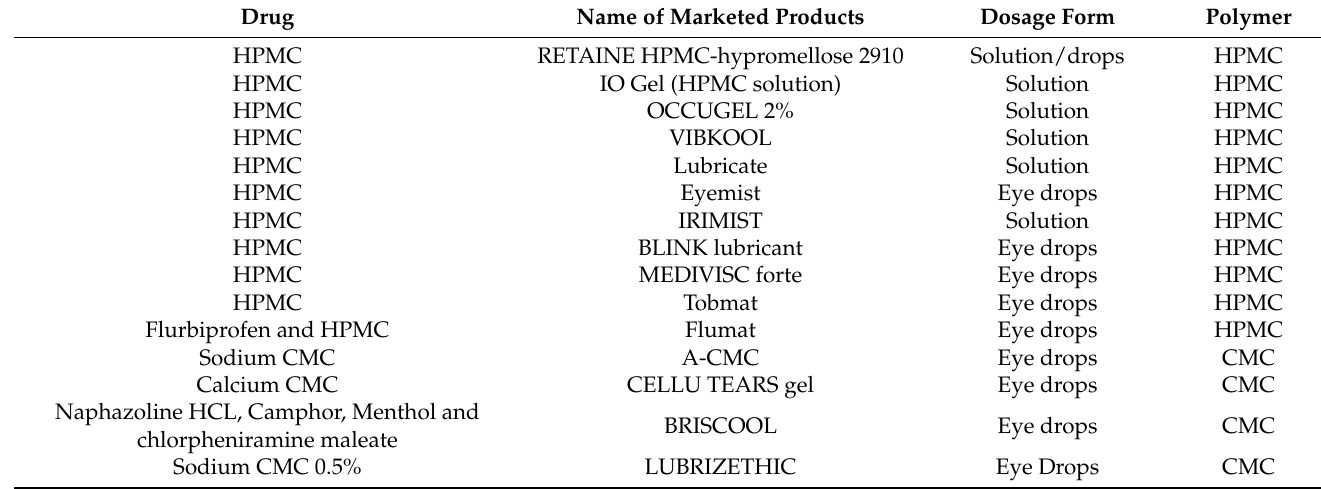
Table 6. Marketed products based on cellulosic polymers for